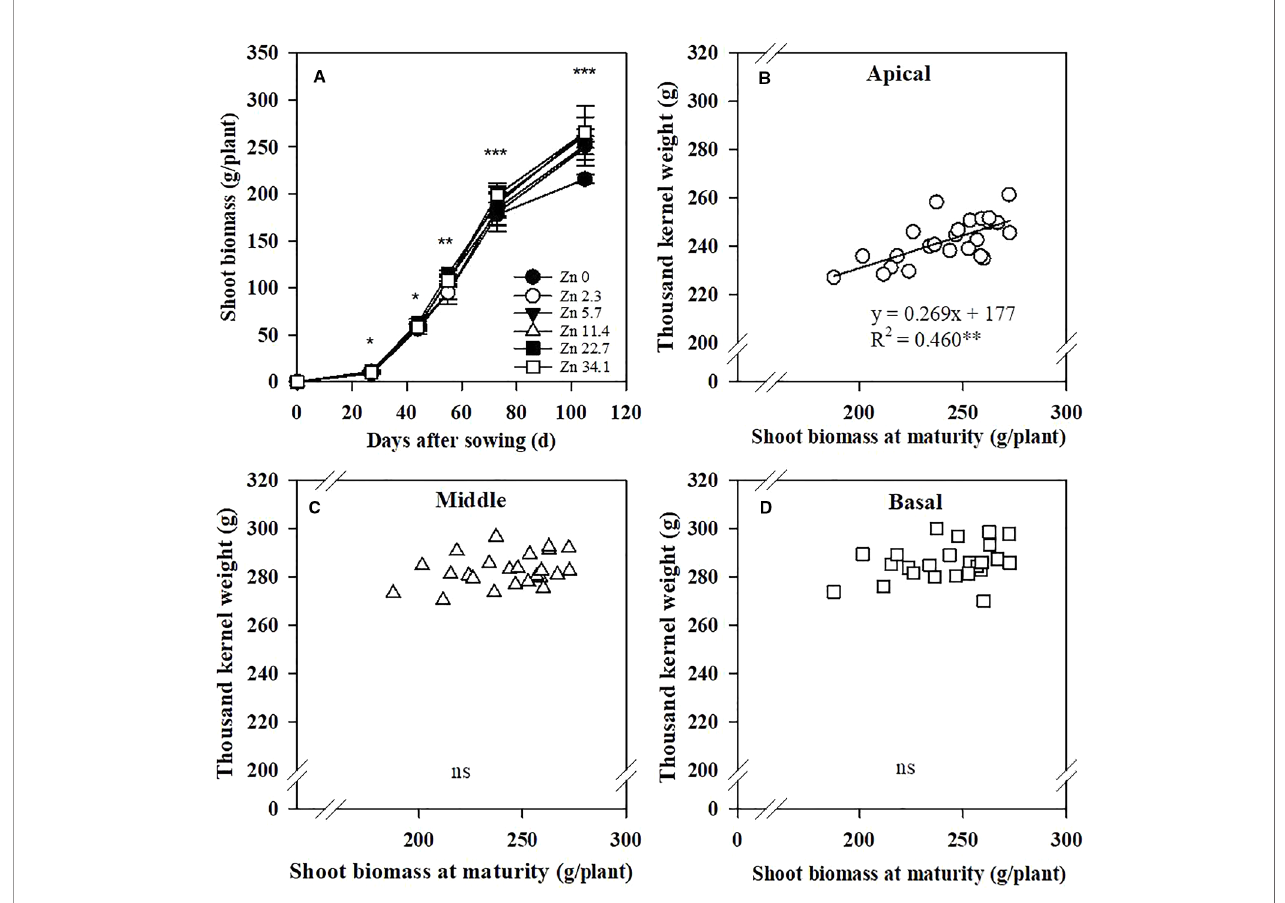
FIGURE 4 | Effects of Zn application rate on shoot biomass at the V6, V12, VT, R3, and R6 stages of maize (A) and correlations of the 1,000-kernel weight of apical (B) , middle (C) , and basal (D) sections of maize spikes with shoot biomass at maturity. Shoot biomass refers to the aboveground biomass, which includes stem, leave, and cob after tasseling (VT) stage. Values are the average ± SE of four replicates. *** P < 0.001, ** P < 0.01, and * P < 0.05. ns, not signi fi